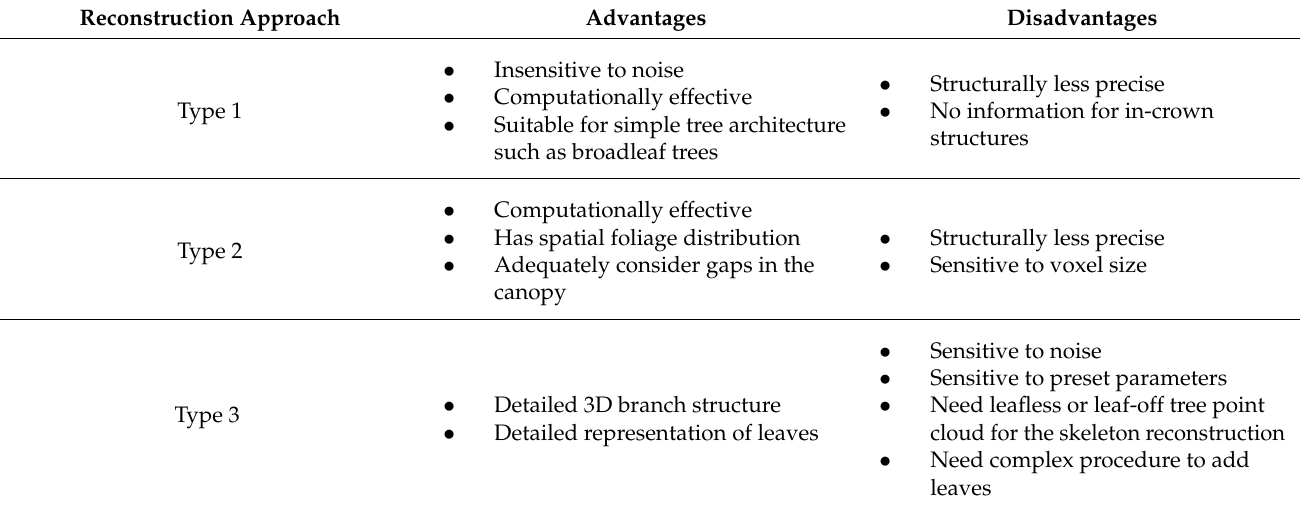
Table 8. Advantages and disadvantages of each reconstruction